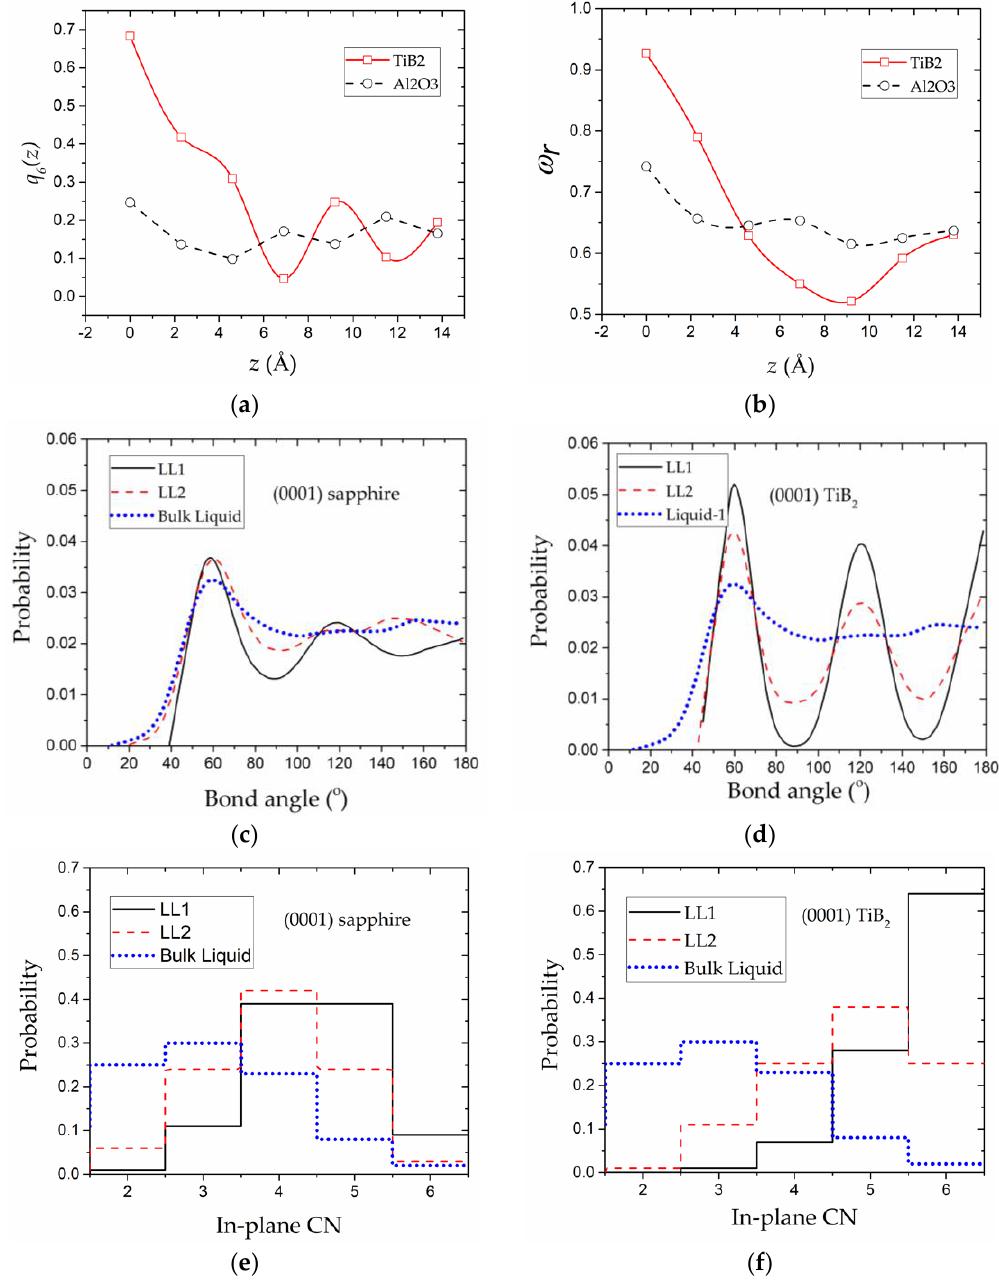
Figure 4. ( a ) Orientational order parameter 𝑞 6 and ( b ) relative in-plane CN calculated for the (0001) sapphire–liquid Al and the (0001) TiB 2 –liquid Al systems. ( c – f ) Bond angle distributions and in-plane coordination number (CN) distributions of the substrate-induced liquid layers.